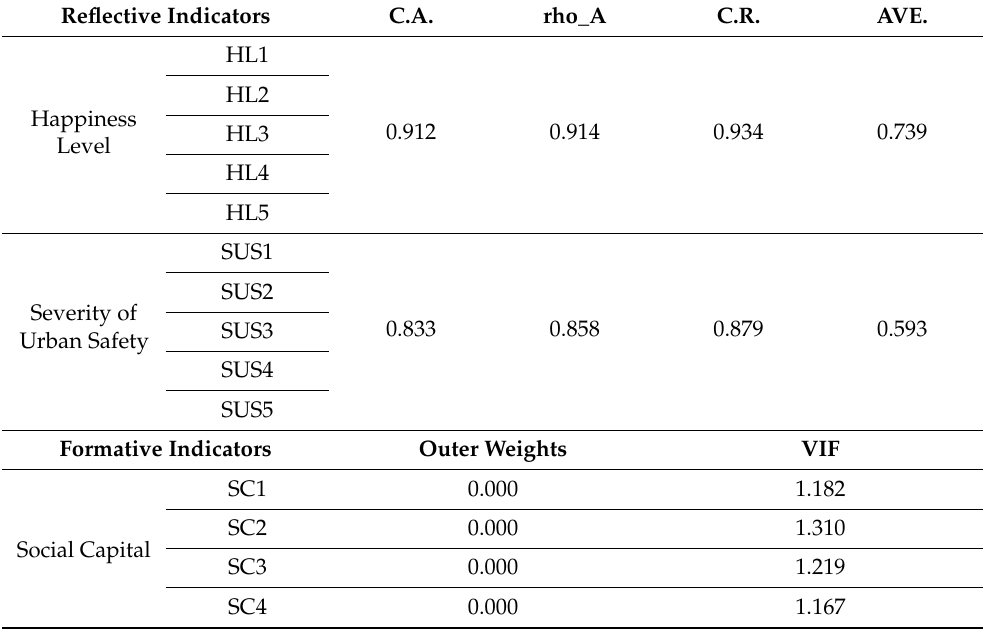
Table 5. Assessment results of mixed model (reflective and